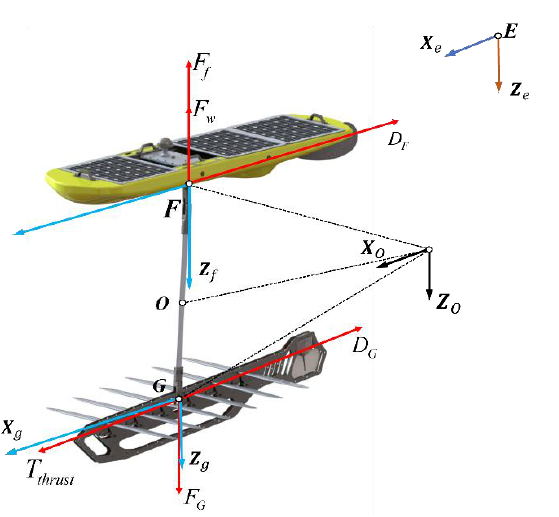
Figure 6. The coordinate system definition and overall force analysis of the wave